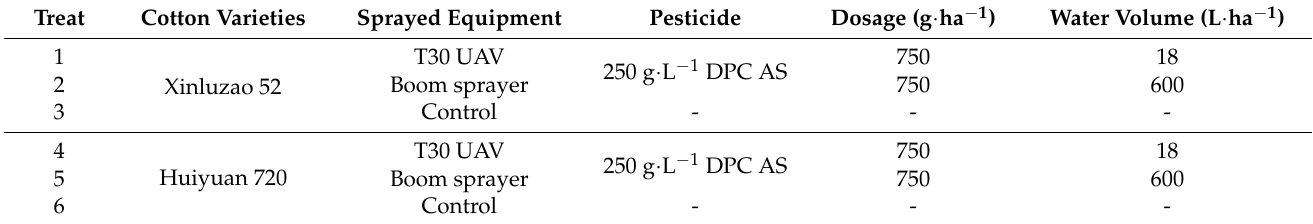
Figure 3. The spraying path for ( a ) Xinluzao 52 and ( b ) Huiyuan 720. Table 2. Design of experiments.